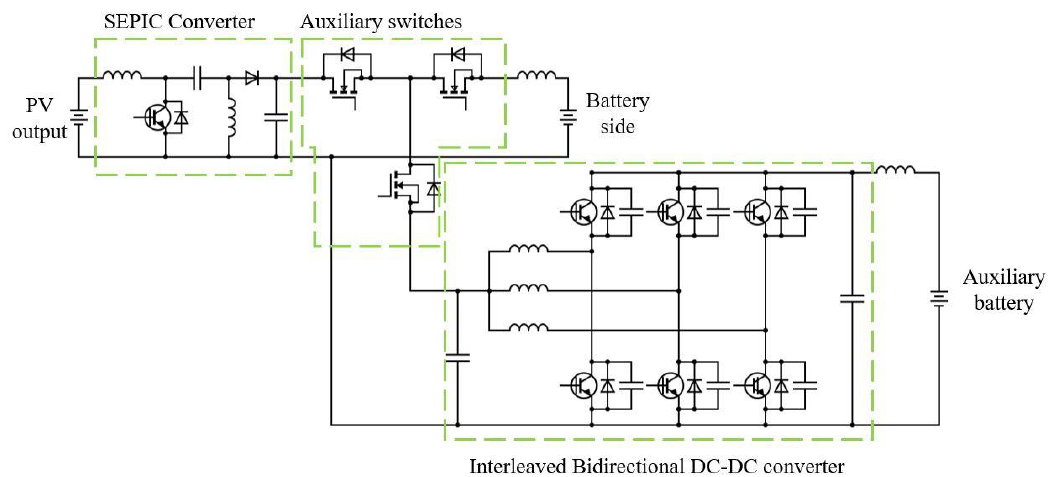
Figure 18. SEPIC and bidirectional interleaved converter-based charger with standalone PV power supply [70].